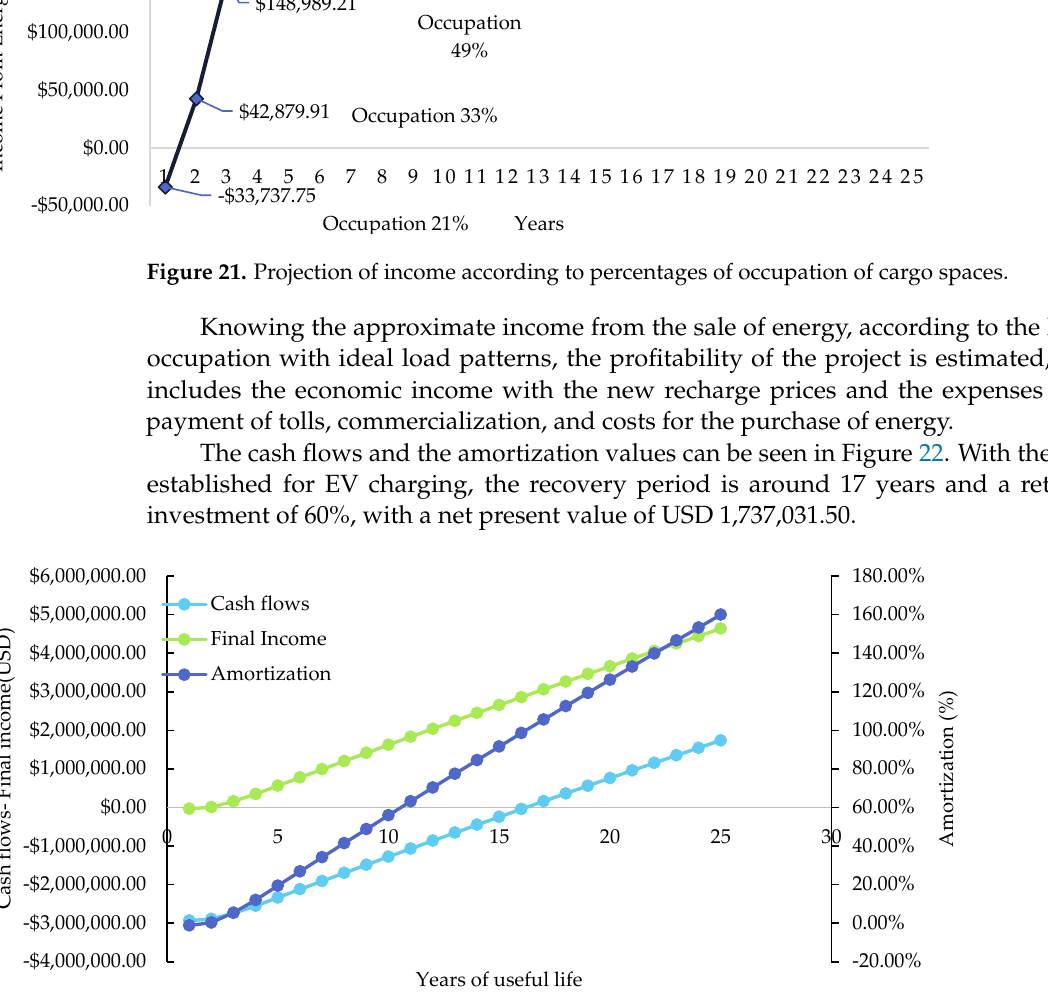
Figure 22. Cash flow, amortization, and total annual income of the proposed methodology.